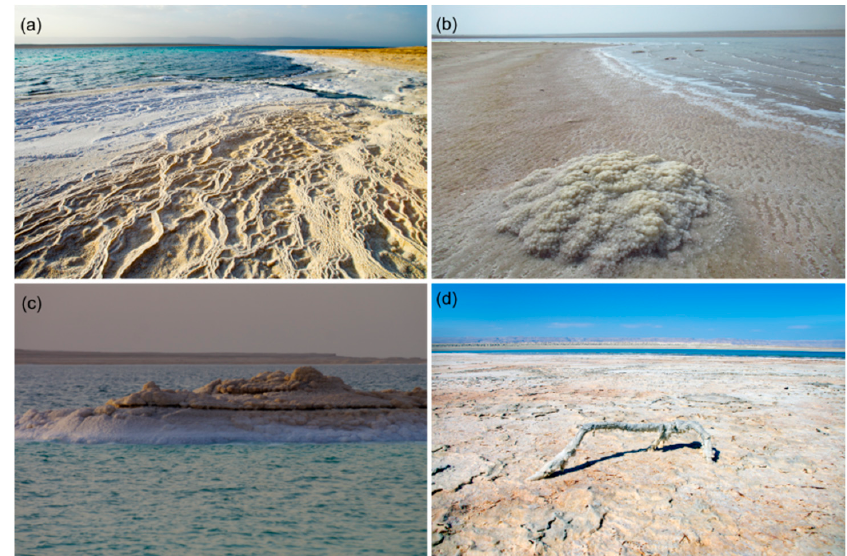
Figure 10. Shoreline of the hypersaline lake with different salt formations. ( a , b ) are salt roses and lines at the recently exposed shoreline, ( c ) is a salt dome that forms in shallow waters, and ( d ) is debris in the delta (here a tree branch) covered by salt due to strong and rapid evaporation. All photos were taken by Djamil Al ‐ Halbouni.